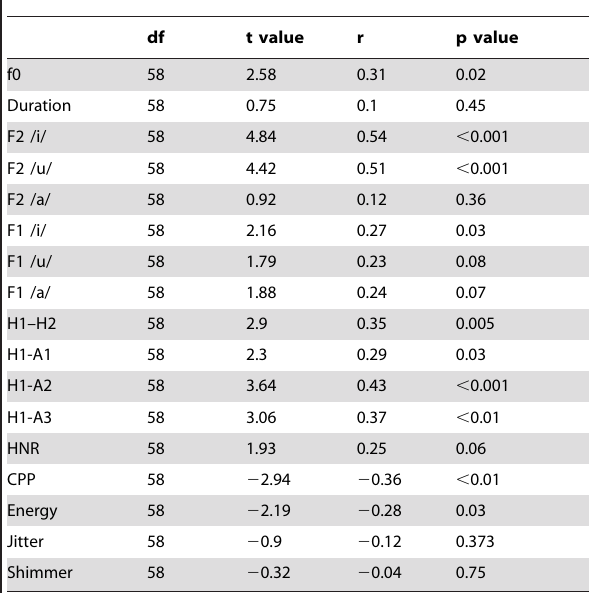
Table 11. Zero-order correlations between vocal attractiveness ratings and each acoustic measure for all 60 voices pooled together.